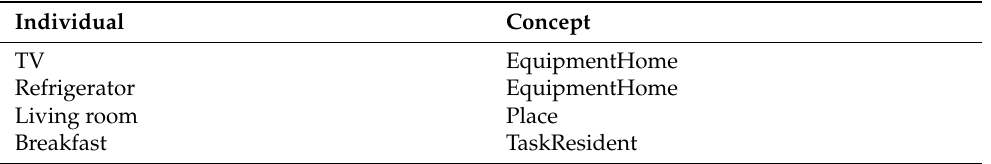
Table 4. Some examples for IRRHEM individuals